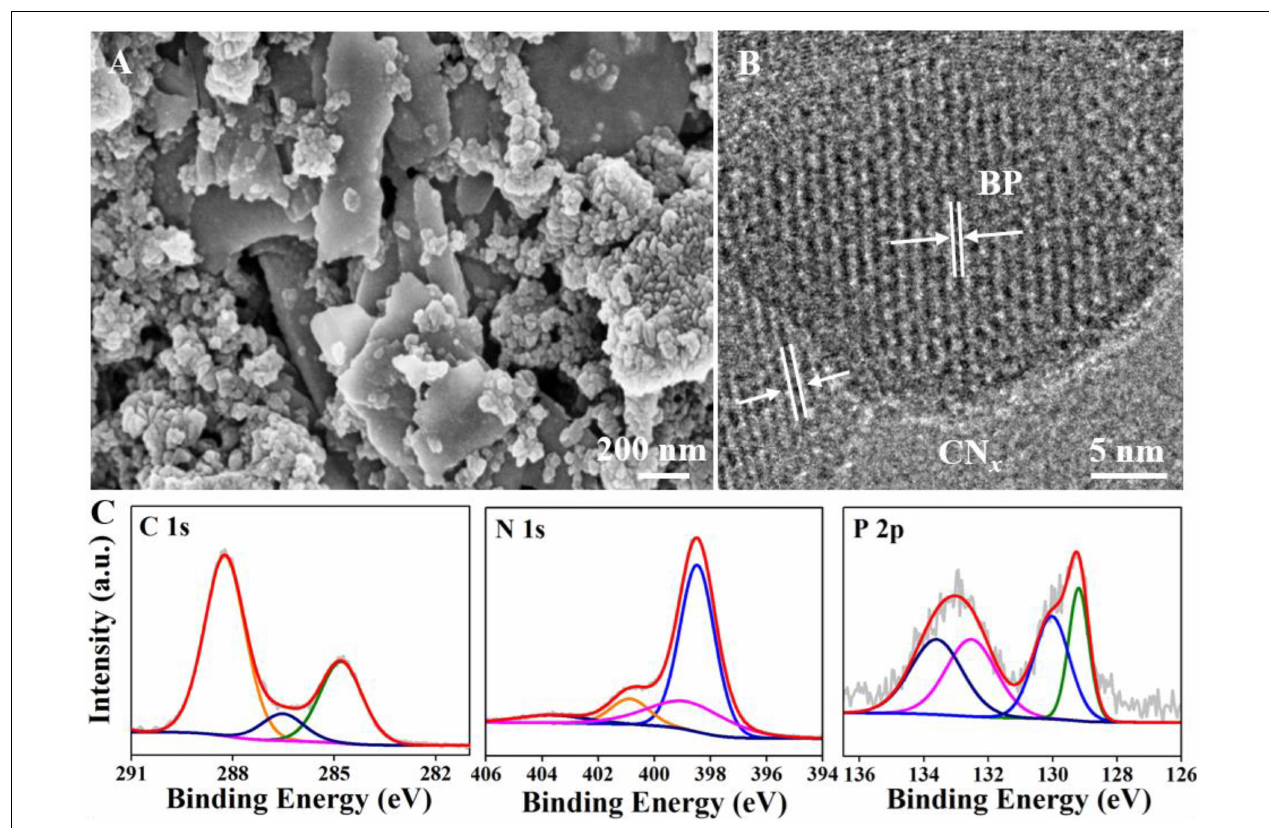
FIGURE 1 | Characterizations of BPCN x . (A) SEM image. (B) TEM image. (C) XPS C 1s, N 1s, and P 2p